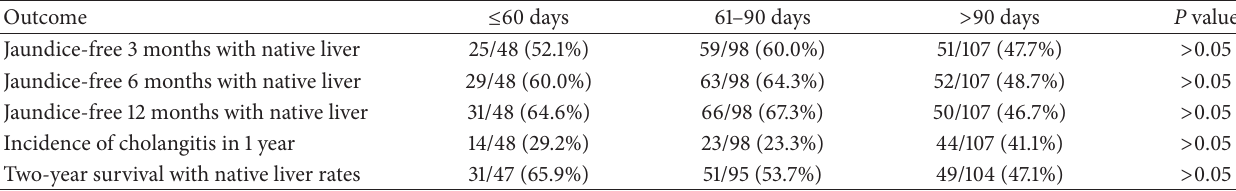
Table 3: Outcome of children receiving high-dose steroid in different time of Kasai operation. Outcome ≤ 60 days 61–90 days > 90 days P